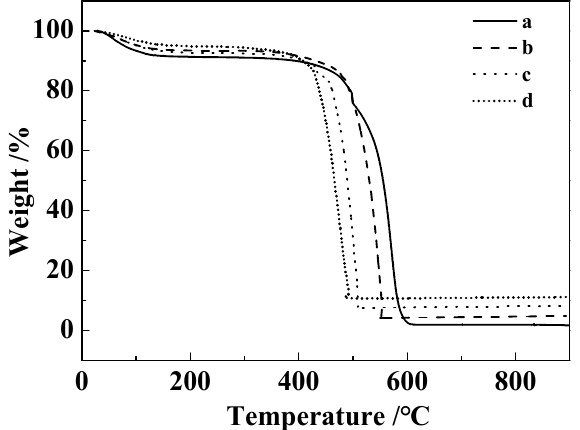
Figure 4. TG thermograms of ( a ) 1CoO x / tri-g-C 3 N 4 , ( b ) 3CoO x / tri-g-C 3 N 4 , ( c ) 5CoO x / tri-g-C 3 N 4 , and ( d ) 7CoO x / tri-g-C 3 N 4 .